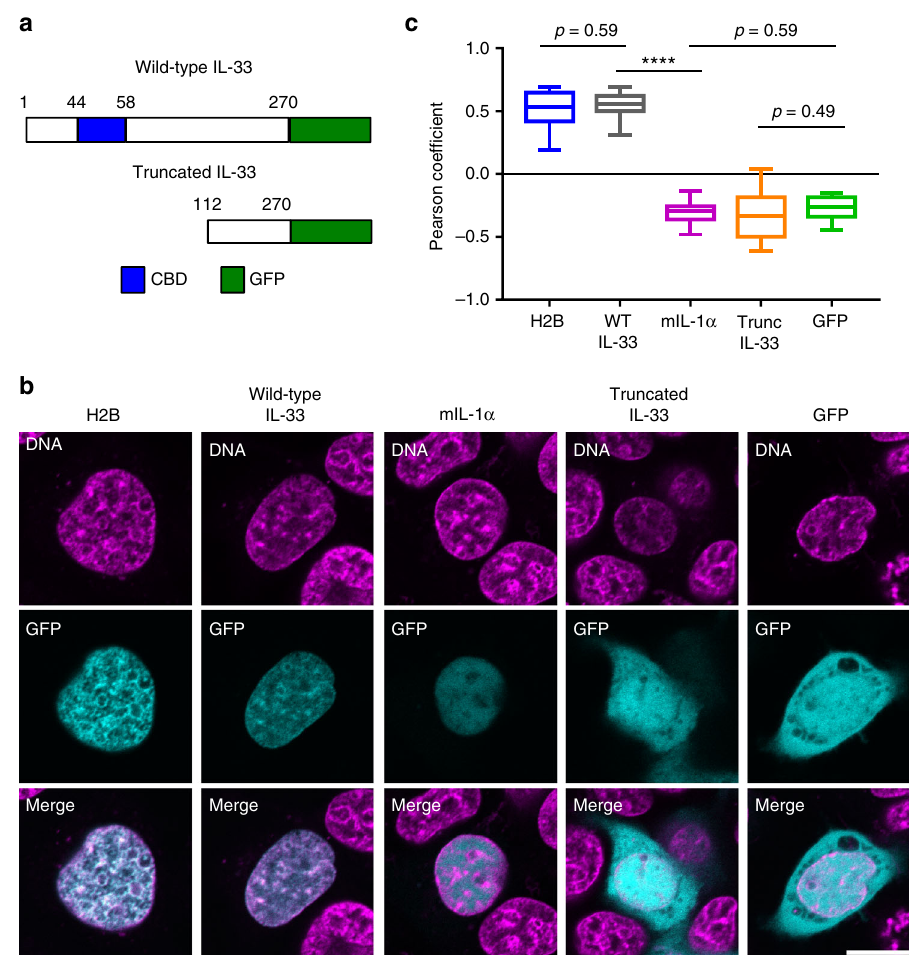
Fig. 3 IL-33 exhibits heterochromatic localization. a Schematic of wild-type and truncated IL-33 – GFP-fusion proteins. b Representative live-cell images from one experiment from c . Top row indicates Hoechst 33342 DNA dye (magenta), middle row indicates presence of GFP-fusion protein (turquoise), and bottom row contains merged images. Scale bar is 10 μ m. c Quanti fi cation of the Pearson correlation coef fi cient within the nucleus between fl uorescence from Hoechst 33342 DNA dye and GFP after transient transfection of plasmid encoding indicated GFP-fusion protein into TE-7 cells. Graph is a box-and- whiskers plot with center line indicating median value, box limits showing upper and lower quartiles, and whiskers indicating the minimum and maximum values. Data are combined from 3 – 5 independent experiments (between 13 and 29 cells each). One-way ANOVA p value was <0.0001, and depicted are p values from Holm – Sidak multiple comparisons test. ANOVA: analysis of variance, CBD: chromatin binding domain, GFP: green fl uorescent